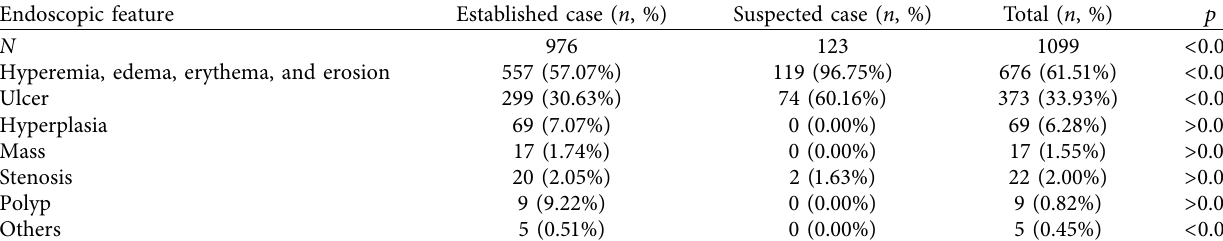
Table 2: Endoscopic findings of patients with terminal ileum lesion.